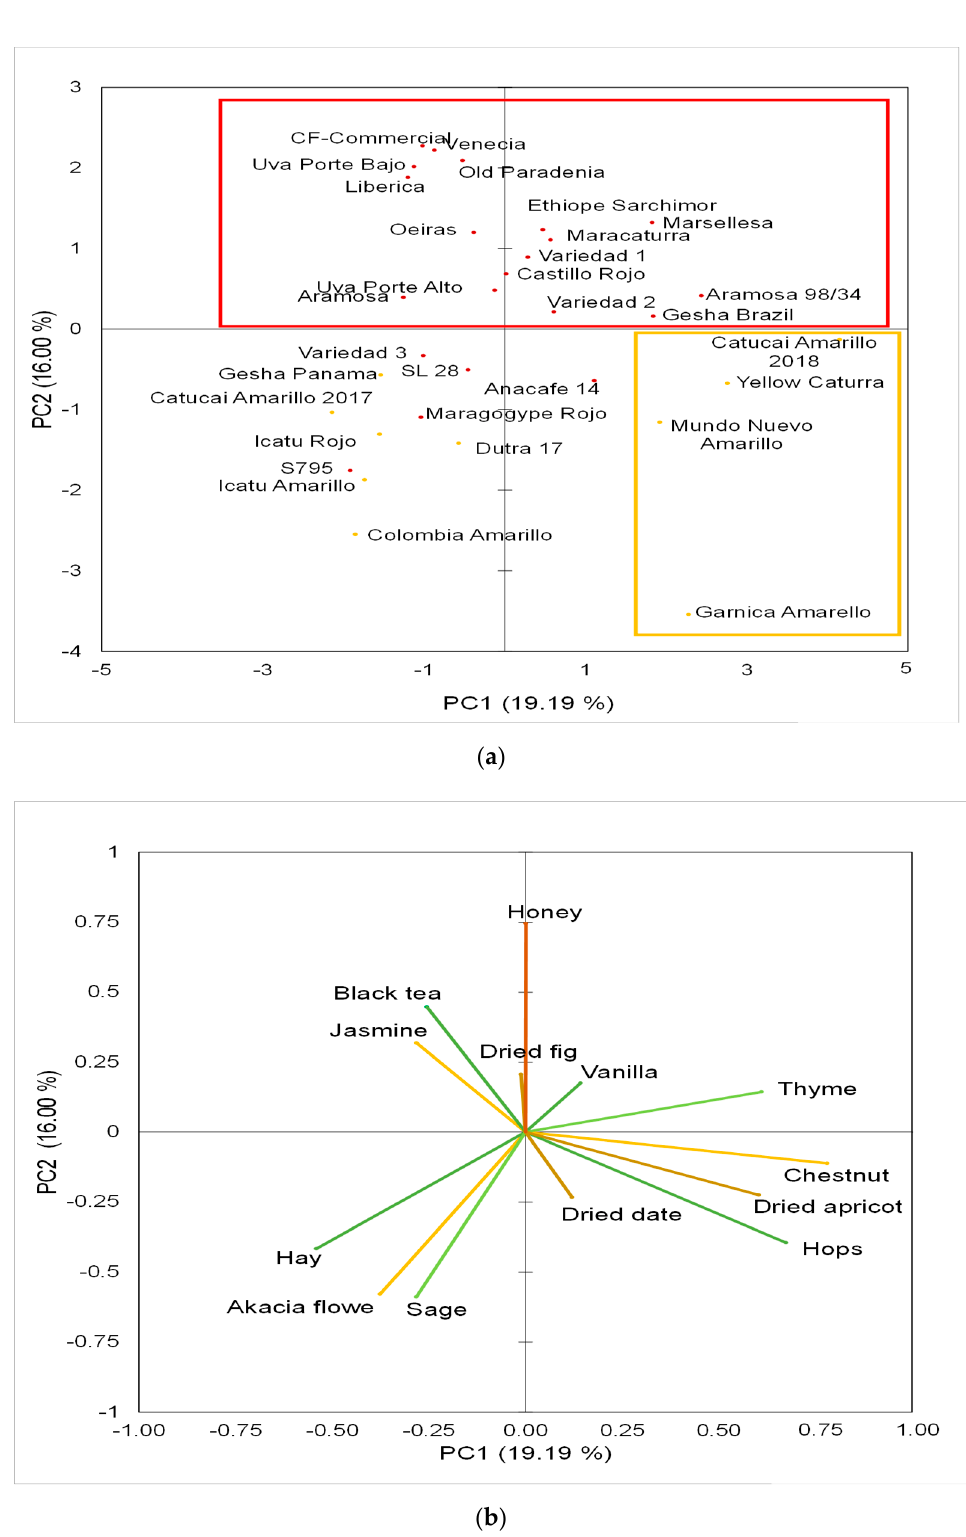
Figure 2. Principal component analysis of the sensory analysis results of the 33 coffee flower sam- ples; ( a ) scores plot; ( b ) loadings plot. ( a ) scores plot; ( b ) loadings